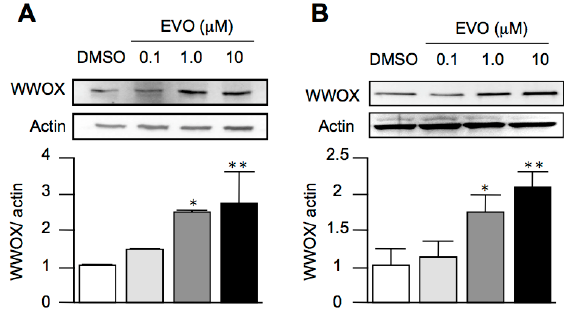
Figure 4. Evodiamine increased the expression of WWOX in both liver cancer cell lines. Mus